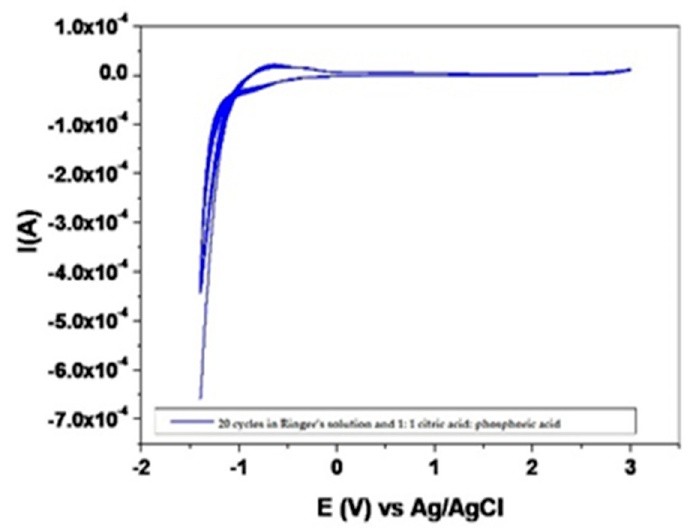
Figure 2. Voltammograms of 20 cycles in 1:1 citric acid: phosphoric acid solution, temperature 25 °C, with a speed of 100 mV/s, for retrieved (patient 1) and new mini-implants.